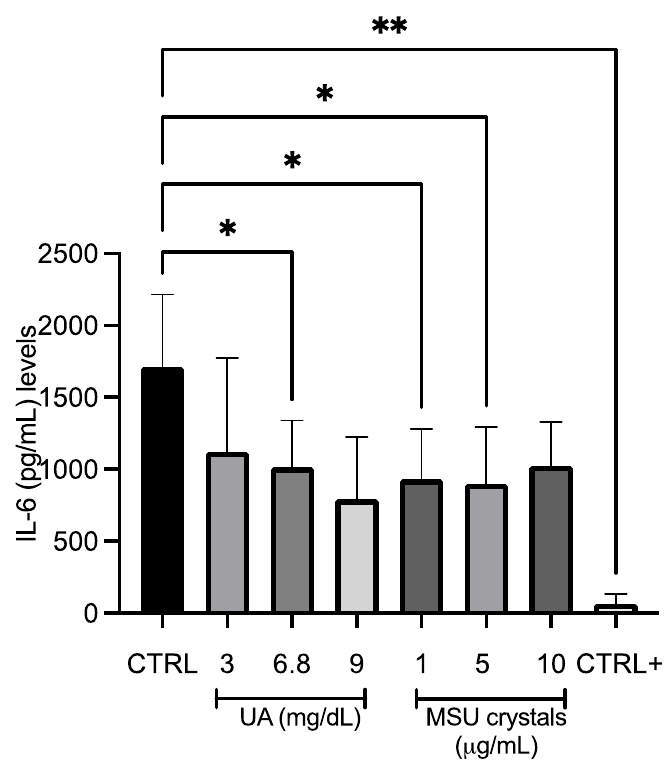
Figure 4. Effect of UA and MSU crystals on IL-6 production by SM-MSCs. Quantification of IL-6 in SM-MSCs treated with different stimuli, i.e., UA (3, 6.8, and 9 mg/dL), MSU crystals (1, 5, and 10 μg/mL), osteogenic medium (control +), and control. The data represent the mean ± SD of independent experiments ( n = 6) (* p < 0.05 vs. control; ** p < 0.001 vs. control).